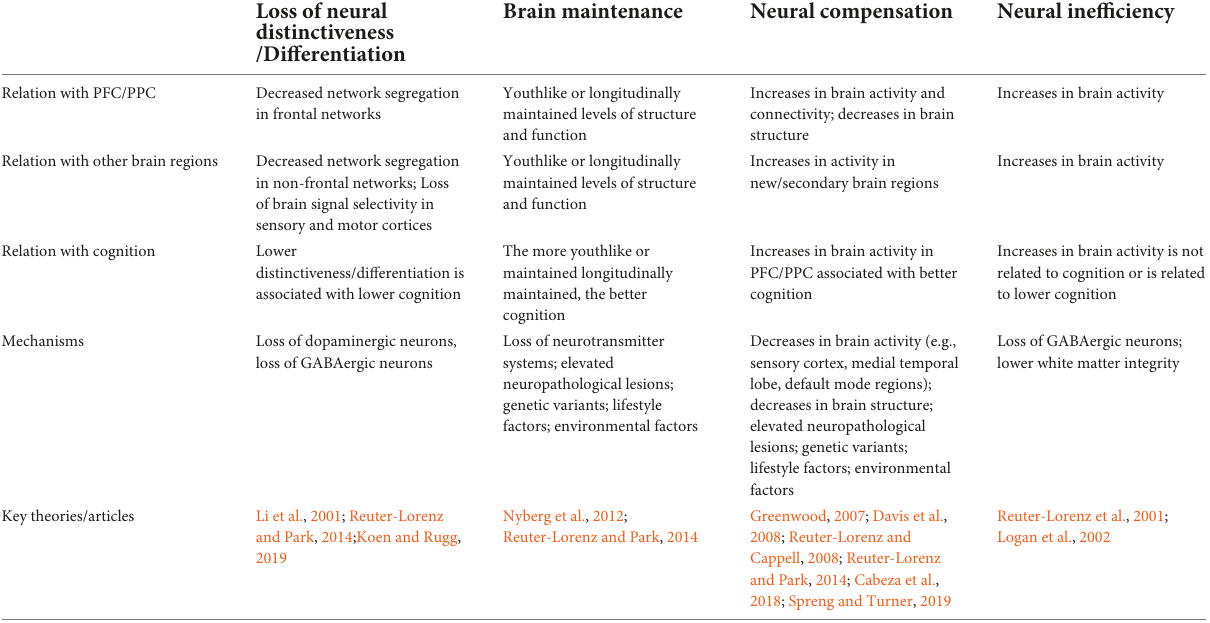
TABLE 1 Summary of key aspects of the four major brain aging